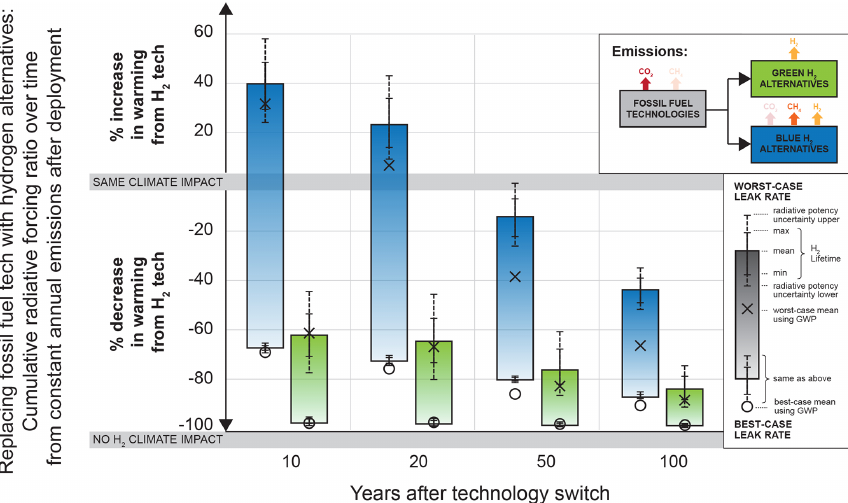
Figure 4. Relative warming impact over time from replacing fossil fuel technologies with green or blue hydrogen alternatives for a generic case. A cumulative radiative forcing ratio for annually deploying 1kg of H 2 vs. annually avoided fossil fuel emissions is used as a proxy for relative warming impacts. Emissions from hydrogen alternatives are hydrogen for green hydrogen and hydrogen and methane for blue hydrogen. Emissions from fossil fuel technologies are carbon dioxide, estimated at 11kgCO 2 avoided per 1kgH 2 deployed, based on estimates from Hydrogen Council (2017). Emissions of hydrogen and methane include a range of plausible leak rates from 1% (best case) to 10% (worst case) per unit H 2 deployed for hydrogen and from 1% (best case) to 3% (worst case) for methane. The height of each bar corresponds to the range of leakage. See Table 2 for the emission inputs for hydrogen and methane; Eqs. (1)–(8) and Table 1 for equations used in the calculation and input parameters, respectively; and Sects. 2.2 and 2.3 for more details on emission assumptions. Error bars represent uncertainties in both hydrogen’s soil sink and lifetime (solid lines) as well as uncertainties in the radiative effects of hydrogen and carbon dioxide ( ∼ ± 20%; dashed lines). The corresponding GWP results (only difference is pulse emissions rather than constant emission rate) are shown using the “x” and “o”